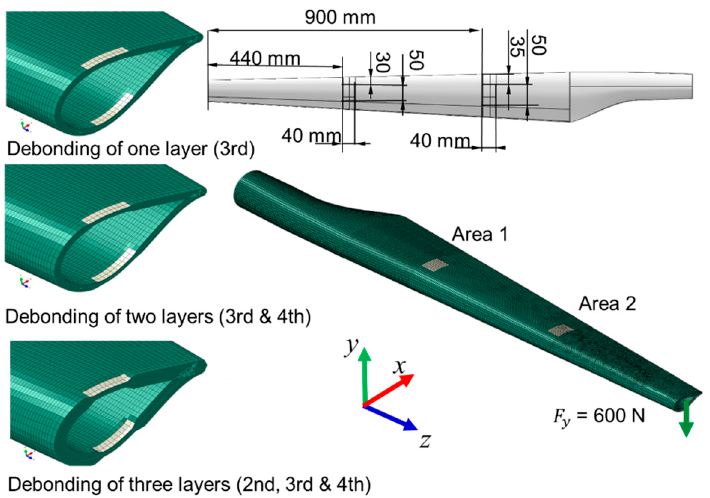
Figure 2. The structure of the wind turbine with the three cases of delamination ( left —the types of delamination; right —the position of areas with delamination).